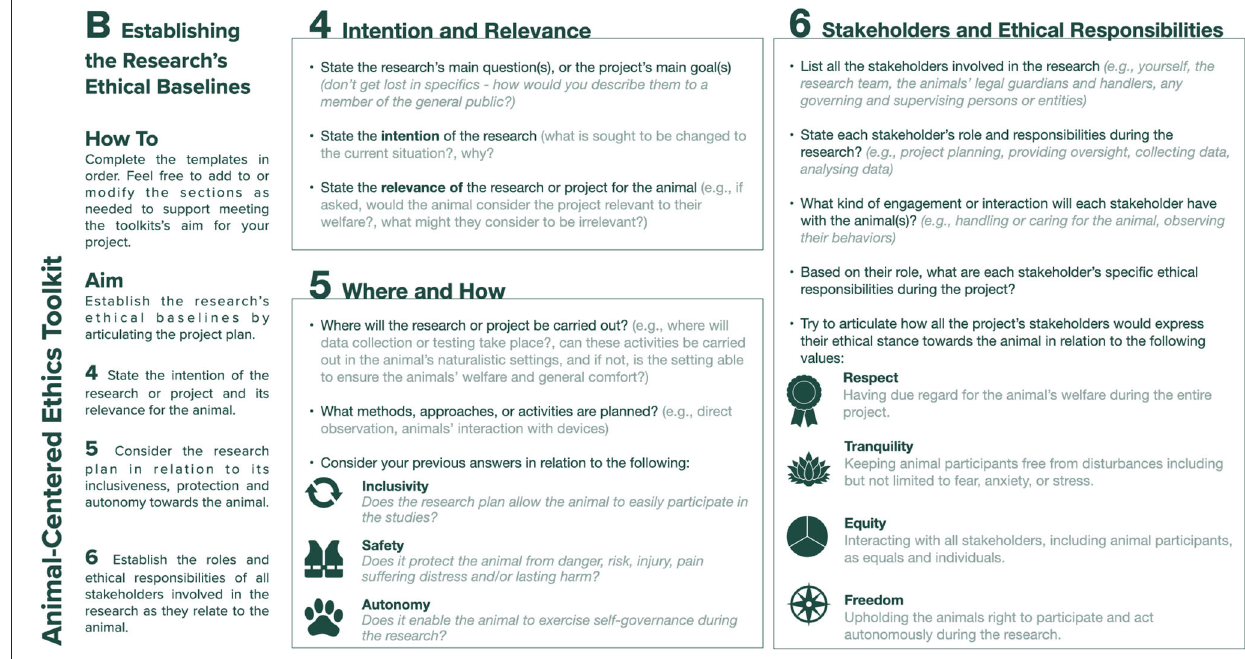
FIGURE 2 | Template B: establishing the research’s ethical